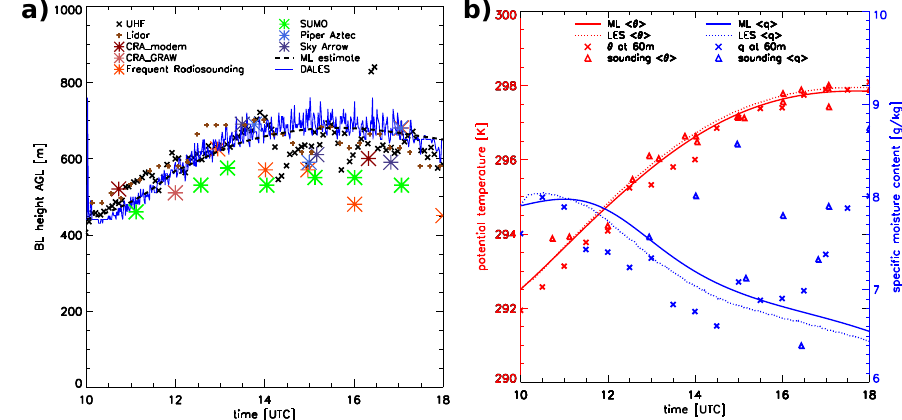
Figure 8. Temporal evolution of (a) boundary-layer height and (b) mixed-layer potential temperature ( θ ) and specific humidity ( q ) on 25 June 2011 (case